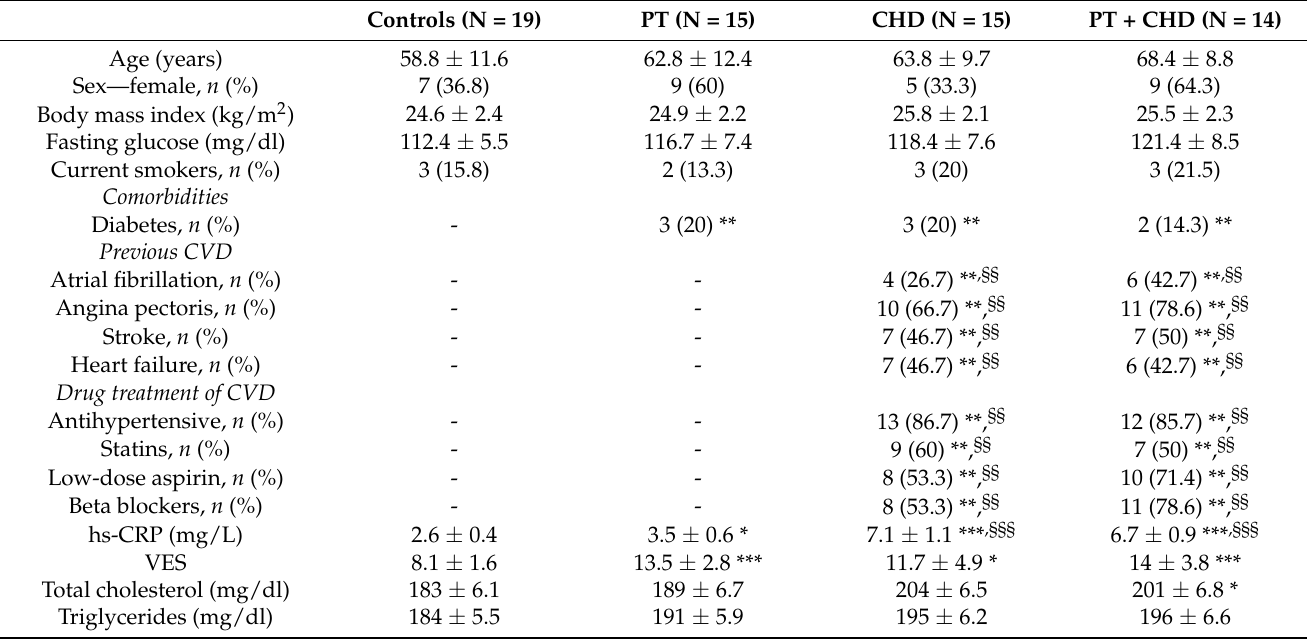
Table 2. Individual characteristics and biochemical parameters of recruited subjects.